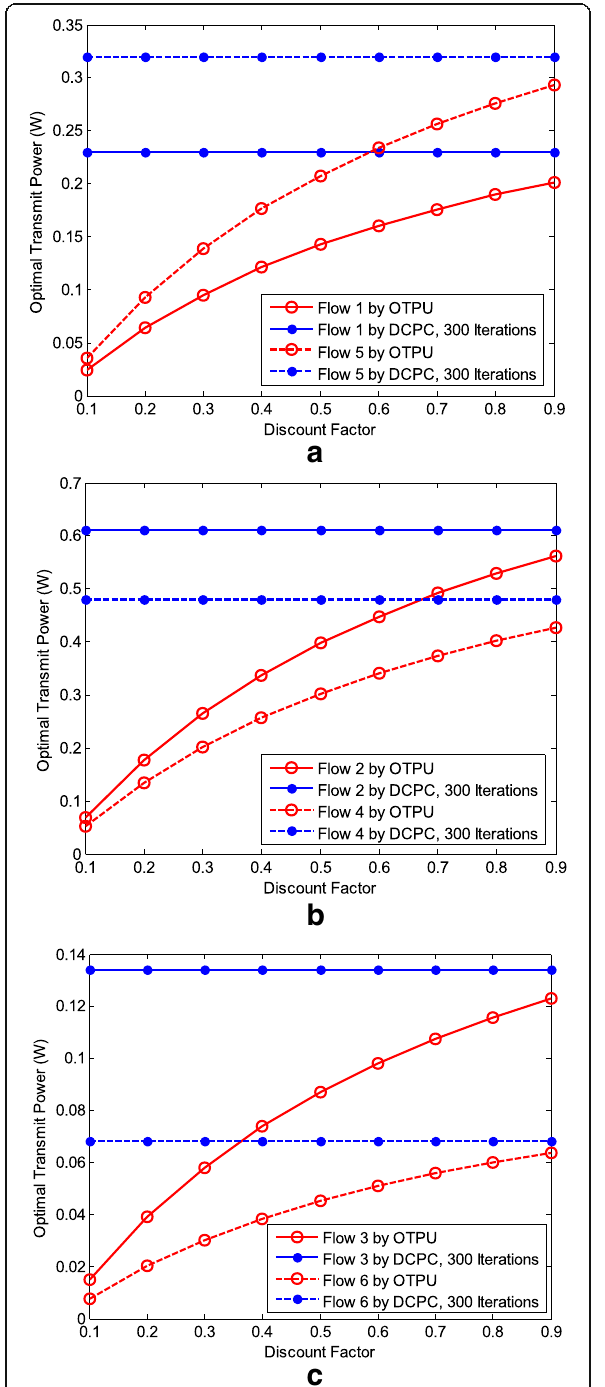
Fig. 8 Optimal transmit power comparison between our proposed OTPU algorithm and DCPC algorithm with 300 iterations under different per-link flows: a Flows 1 and 5, b flows 2 and 4, and c flows 3 and 6